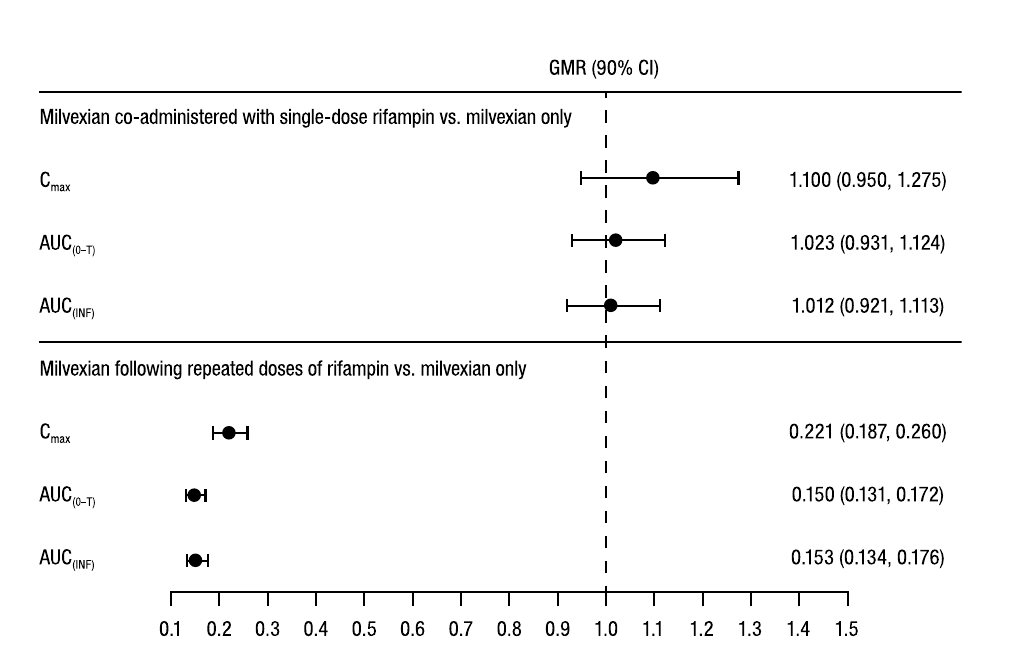
Table 3. Pharmacokinetic parameters. C max , maximum observed plasma concentration; AUC (0–T) , area under the plasma concentration–time curve from time 0 to time of last quantifiable concentration; AUC (INF) , area under the concentration–time curve from time 0 extrapolated to infinite time; T max , time of maximum observed plasma concentration; T 1/2 , terminal plasma half-life; CI, confidence interval; SD, standard deviation. C max , AUC (0–T) , and AUC (INF) are presented as adjusted geometric mean (90% CI). T max is presented as median (minimum–maximum). T 1/2 is presented as mean (SD).